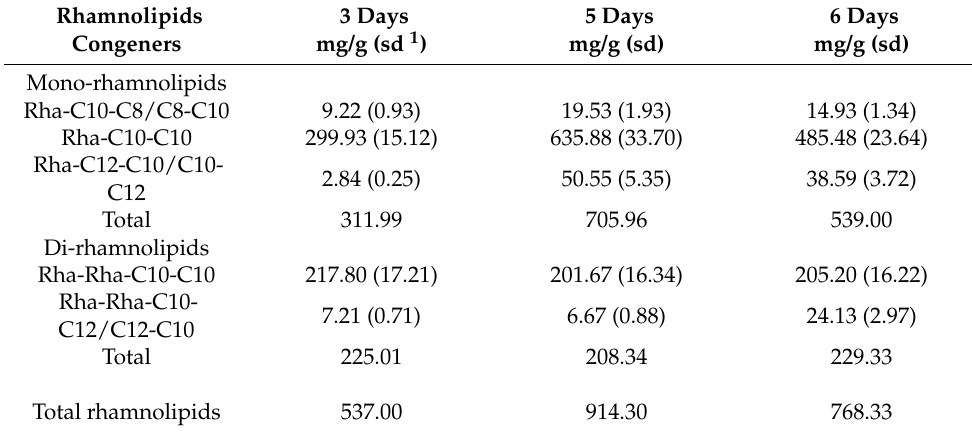
Table 2. Concentrations of rhamnolipids congeners in R89BS crude extracts at different incubation times (3, 5 and 6